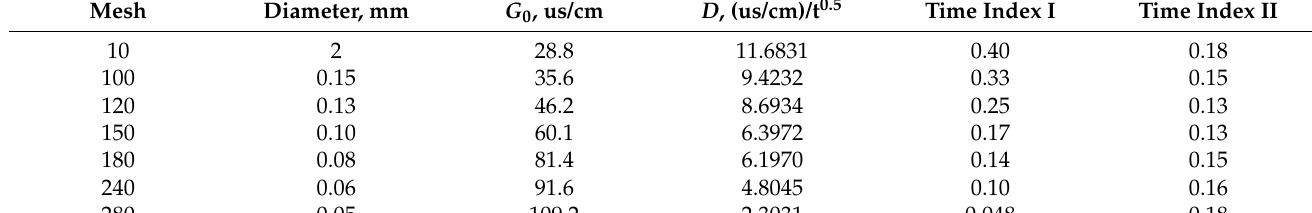
Table 4. Basic parameters for ion diffusion in tight sandstone samples.